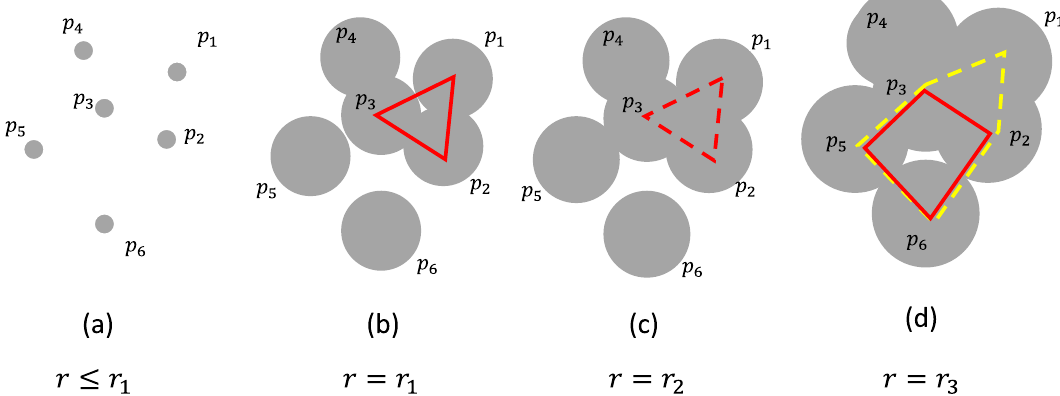
Figure 2. Schematic explanation of PH. ( a ) When the radius of balls r was small, all balls were disconnected. ( b ) When r increased, a cycle that surrounds the empty space is created, as indicated by the red triangle. ( c ) A further increase in r destroyed the cycle. ( d ) Several polygons may surround the empty space, as shown by the yellow and the red polygons. The volume optimal cycle was defined as the minimal cycle that surrounded the empty space. In this case, the red and yellow polygons consisted of two and three triangles, respectively, and the red polygon is the optimal